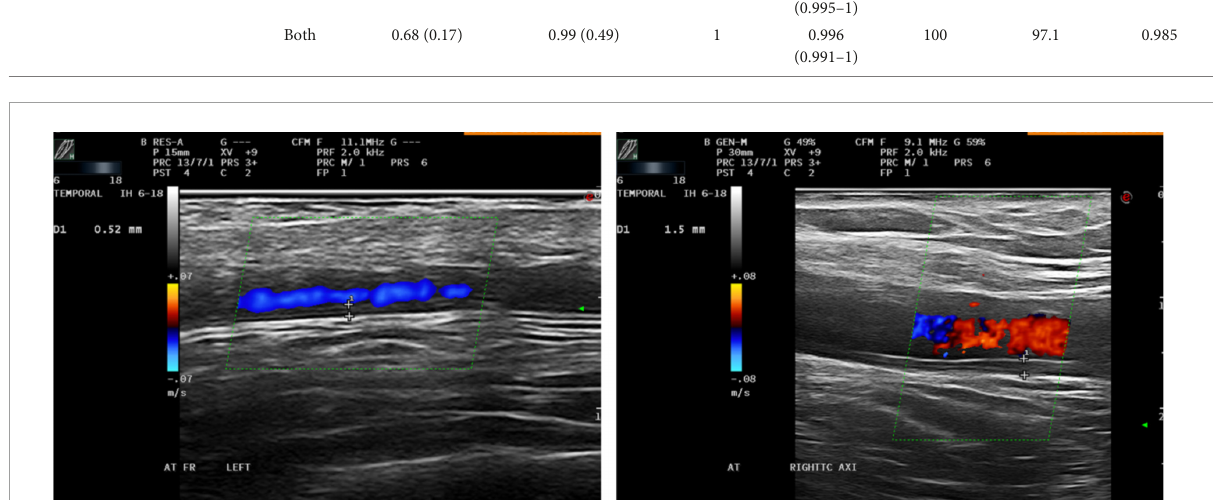
FIGURE1 Longitudinal US scan (left) of the frontal branch of the left temporal artery in a patient with newly GCA diagnosis. Longitudinal US scan (right) of the right axillary artery in patient with large vessel GCA. Both arteries show increase IMT above the proposed cut-off values.